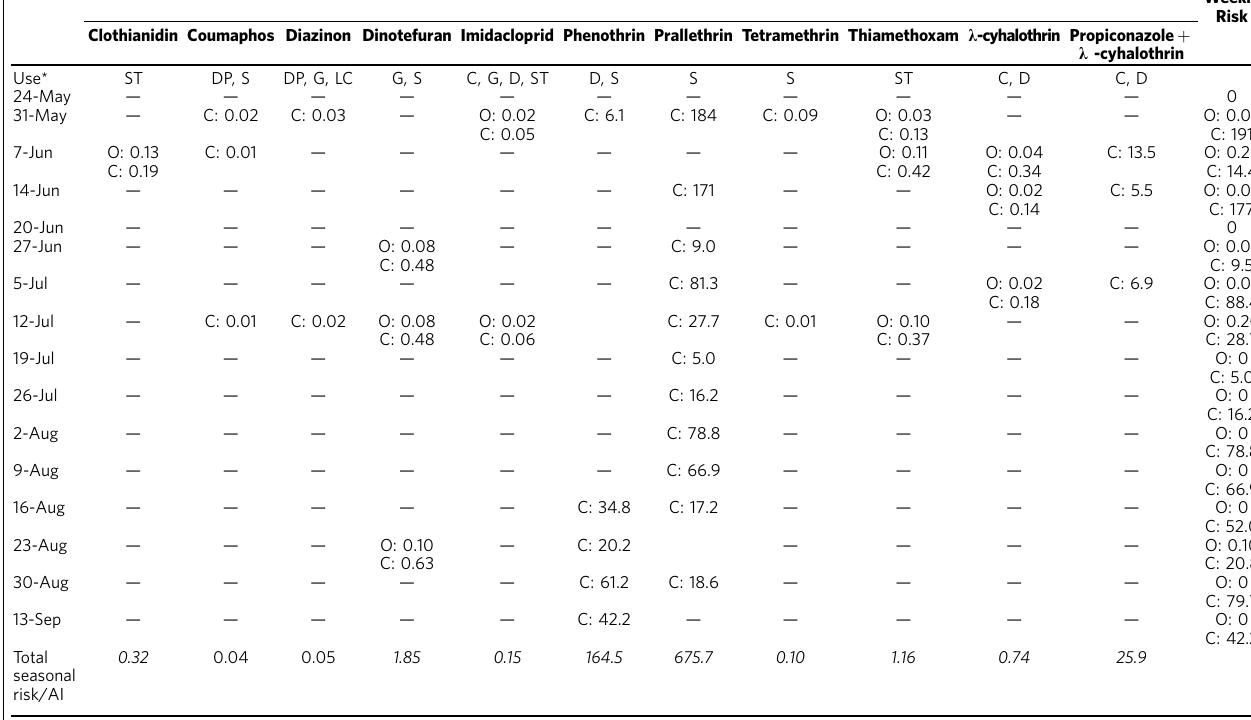
Oral(O)andcontact(C)risksarebasedontheresidueload,frequencyofdetection,andreportedindividualorsynergisticlethaldoses(LD 50 )ofactiveingredients.Lowriskvalues: 0.1–1.0;Moderaterisk values: 1–5; High risk values: 4 5. Risk values o 0.01 not shown. Note: Dashes denote no detection of active ingredients. Italicized values denote relevant seasonal risk values for honey bees. *C, liquid, soluble, or emulsifiable concentrate; D, dusts or dustable powder; G, granules; S, spray; SD, soil drench; ST, seed